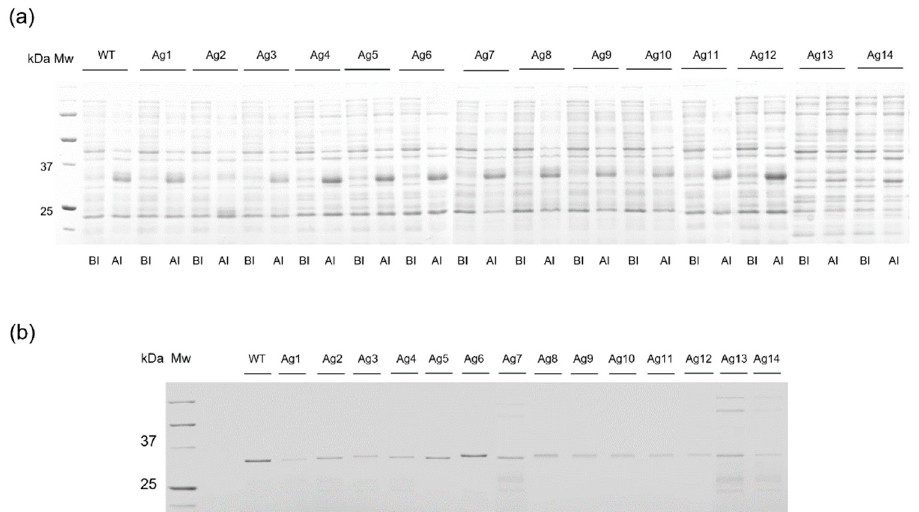
Figure 2. Expression and purification of AgUox-frTet variants. ( a ) Coomassie blue-stained protein gels of AgUox-WT and AgUox-frTet (Ag1–14) variants. Lanes: MW, molecular weight marker; BI, before induction; AI, after induction. ( b ) Image of Coomassie blue-stained protein gels of AgUox-WT and AgUox-frTet variants after purification.